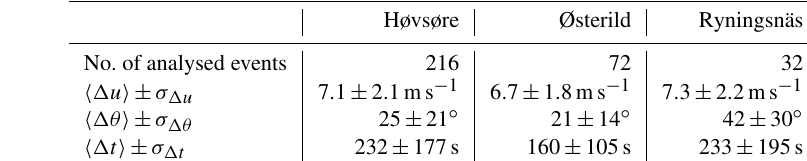
Table 1. The number of analysed events and average estimated variables from each site.